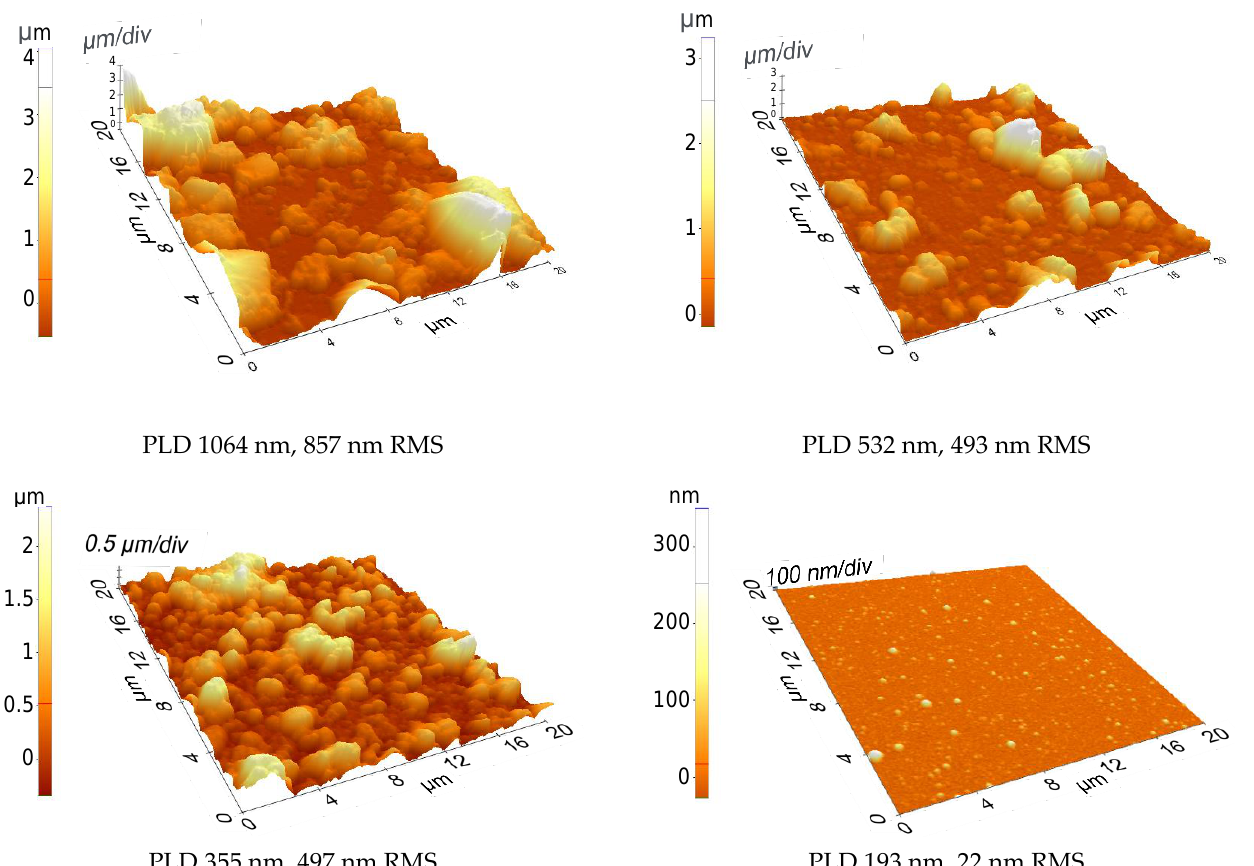
Figure 6. AFM image of films deposited by MAPLE; RMS roughness is 486 nm. AFM images and RMS roughness of films deposited by PLD.